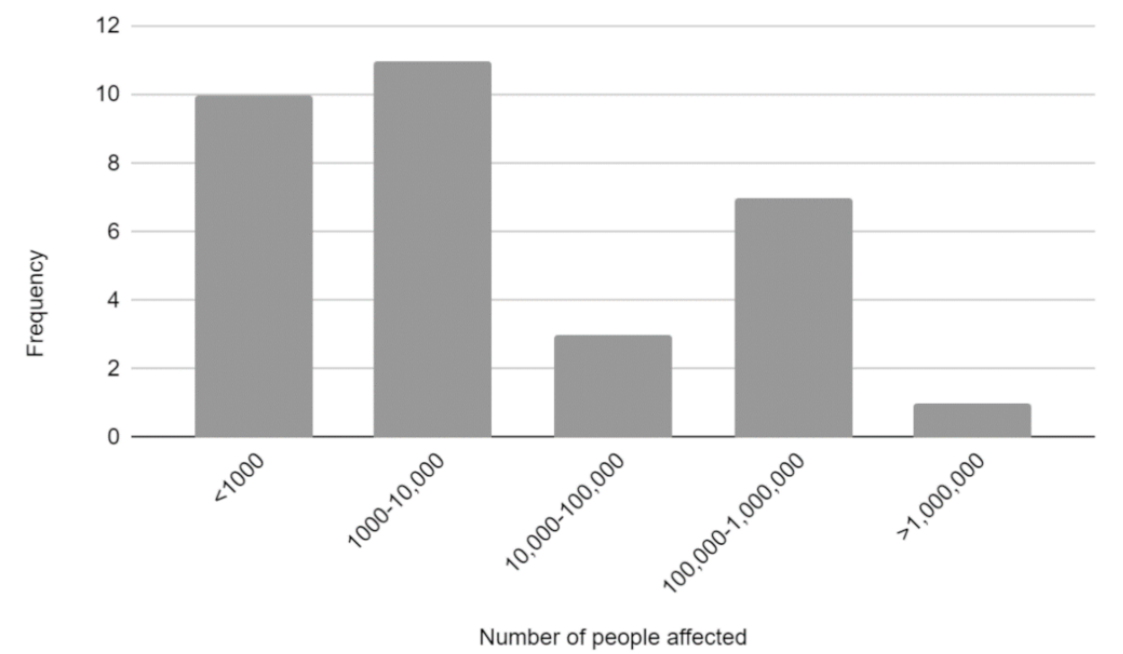
Figure 9. Grouped sizes of populations impacted by programmes presenting evidence of time-saving.